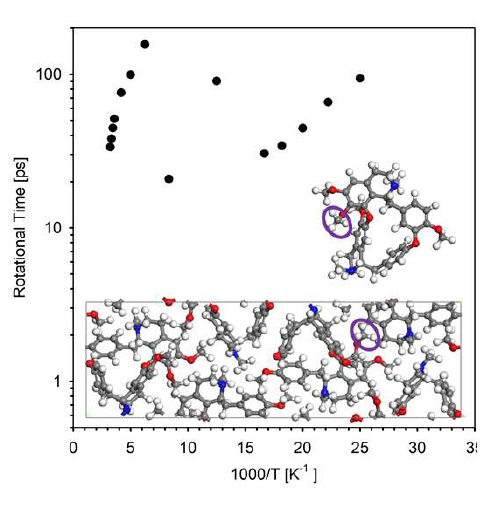
Fig. 4 . Arrhenius plot of the measured relaxation times (symbols) for the methyl group rotation in a molecular drug tetrandrine (the data points are adapted from [14]). Insets: molecular structure (top) and crystal structure (bottom) of tetrandrine. The methyl group with the lowest rotational barrier, giving rise to the low- temperature data points, are encircled by an oval. The other methyl groups have higher rotational barriers and give rise to the high-temperature data points.